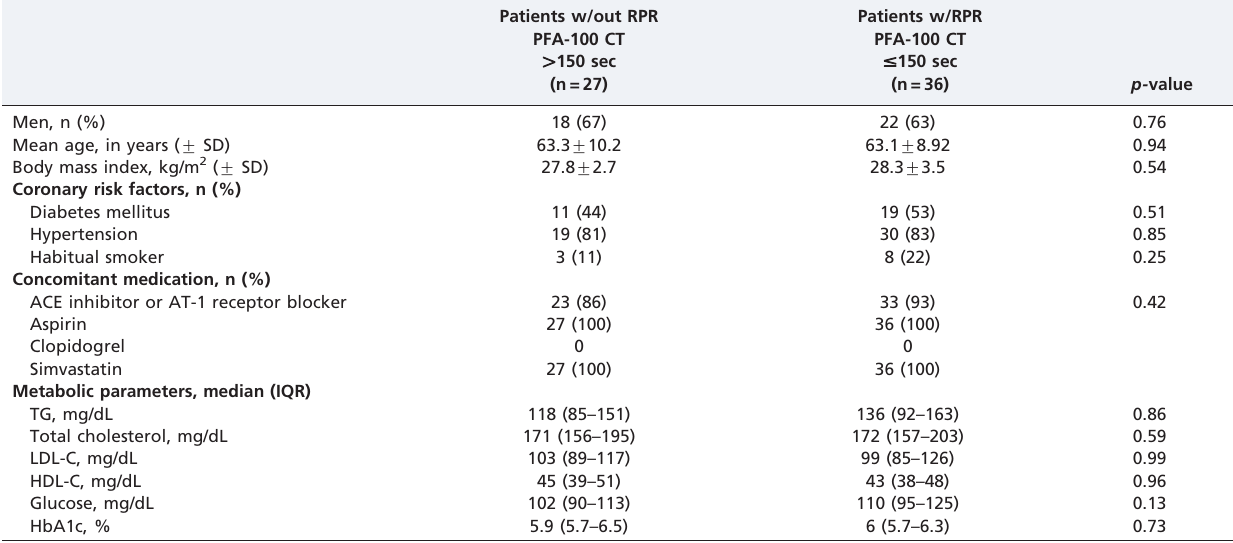
Table 1 - Baseline patient characteristics according to the PFA-100 CT